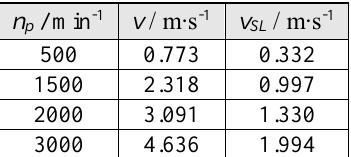
Tab. 1. Flow velocities v (outlet duct) and flow velocities v SL (suction line) corresponding to the pump revolutions n p and the flow area